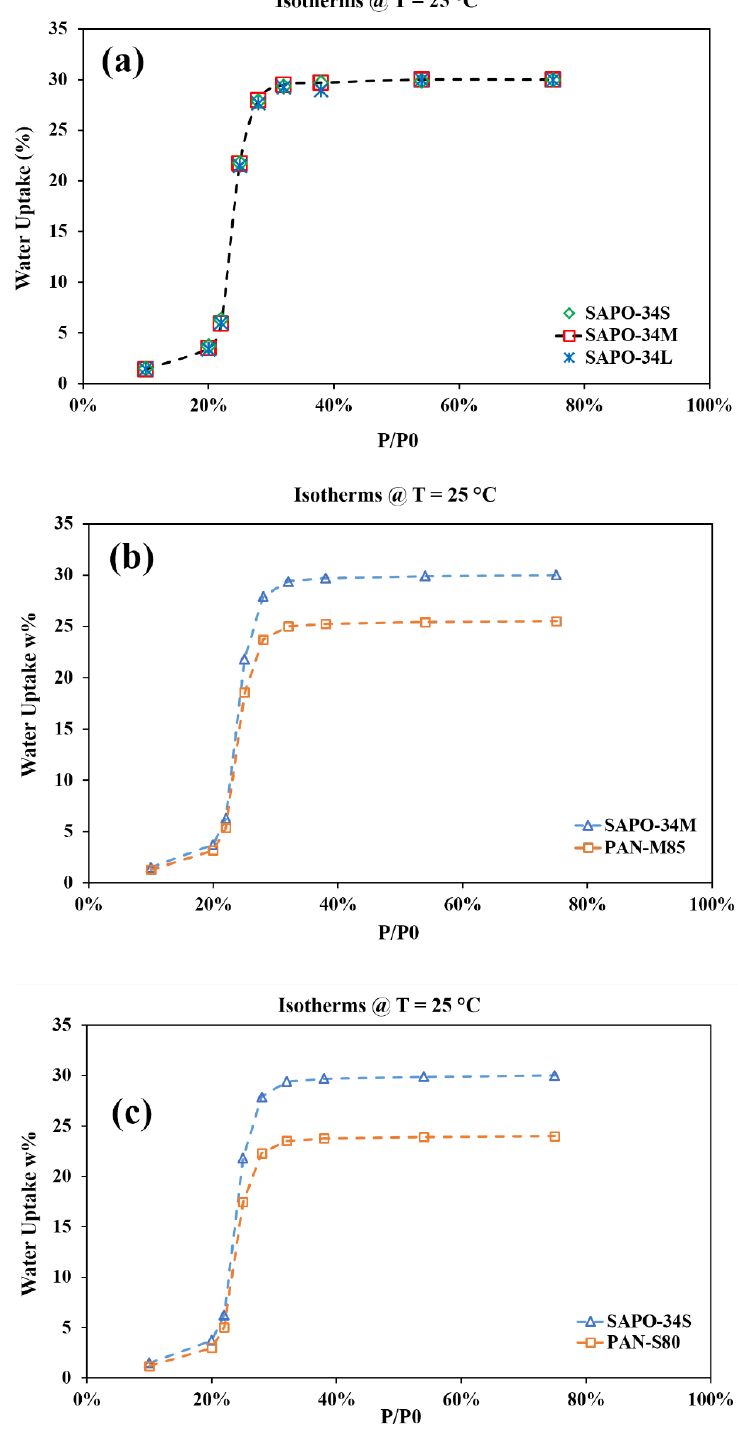
Figure 7. Isotherms of SAPO-34 zeolites ( a ), PAN-M85 ( b ) and PAN-S80 ( c ).